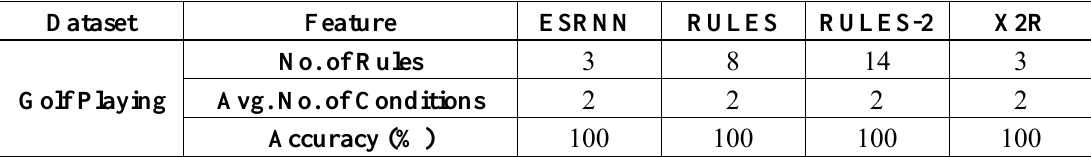
Table 14. Performance comparison of ESRNN with other algorithms for golf playing data.